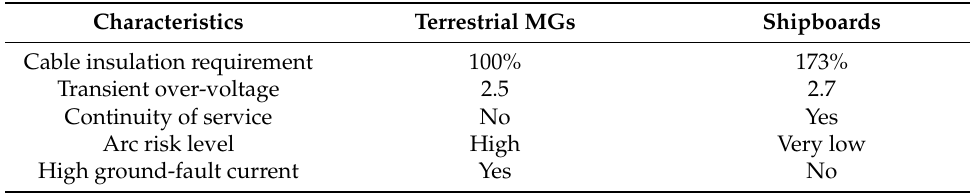
Table 2. Characteristics of different grounding structures, adapted from